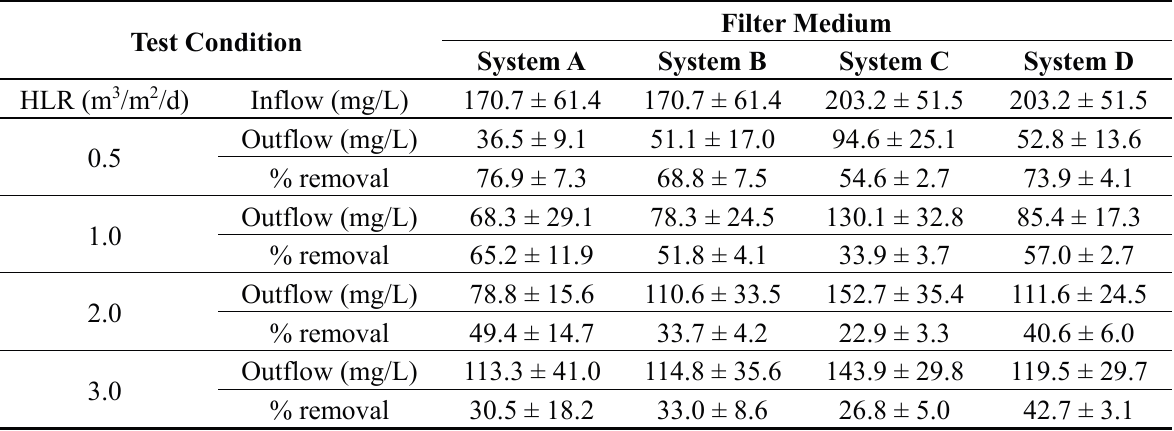
Table 3. COD removal performance under different HLR